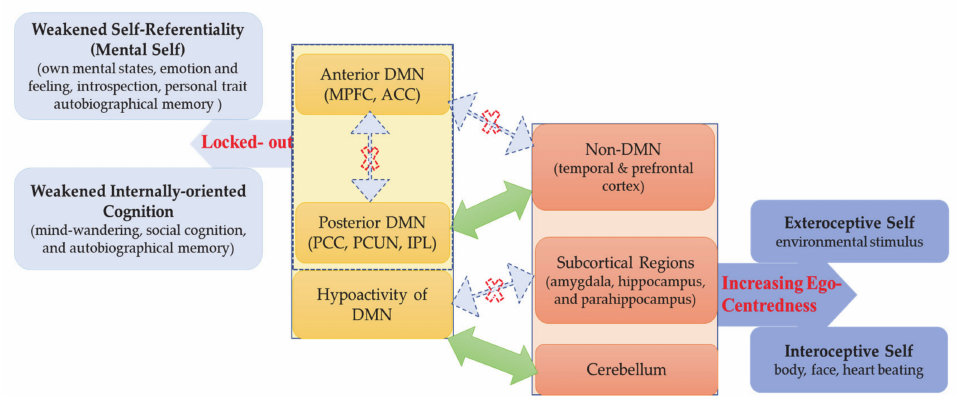
Figure 7. Hierarchical Model of Autistic Self (HAS): locked-out mental-self and increased ego-centeredness in individuals with